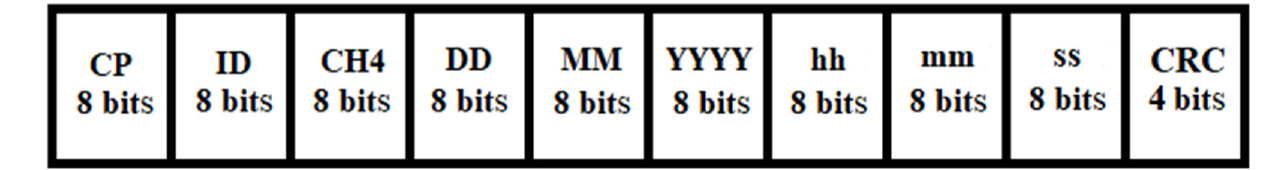
Figure 19. The data transmission algorithm within the mining lamps.